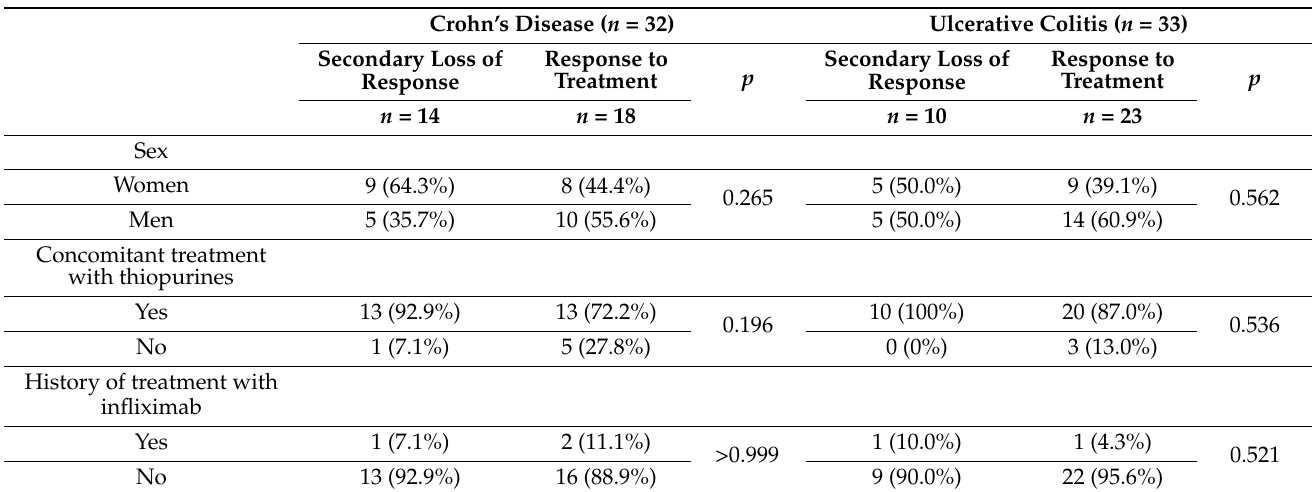
Table 5. Secondary loss of response.